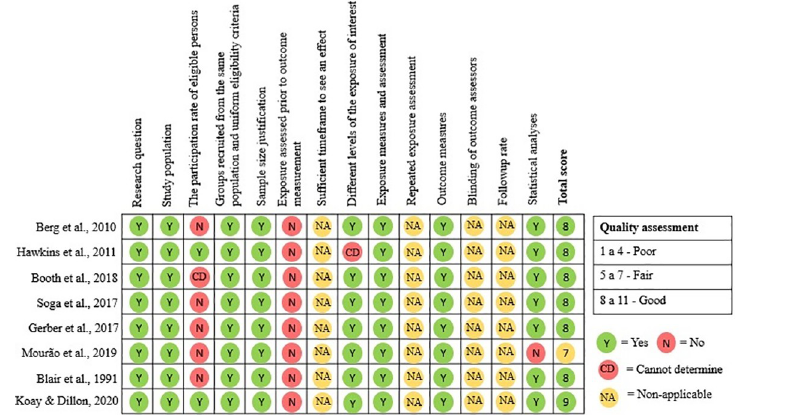
Fig 2. Quality assessment of the studies included in this literature